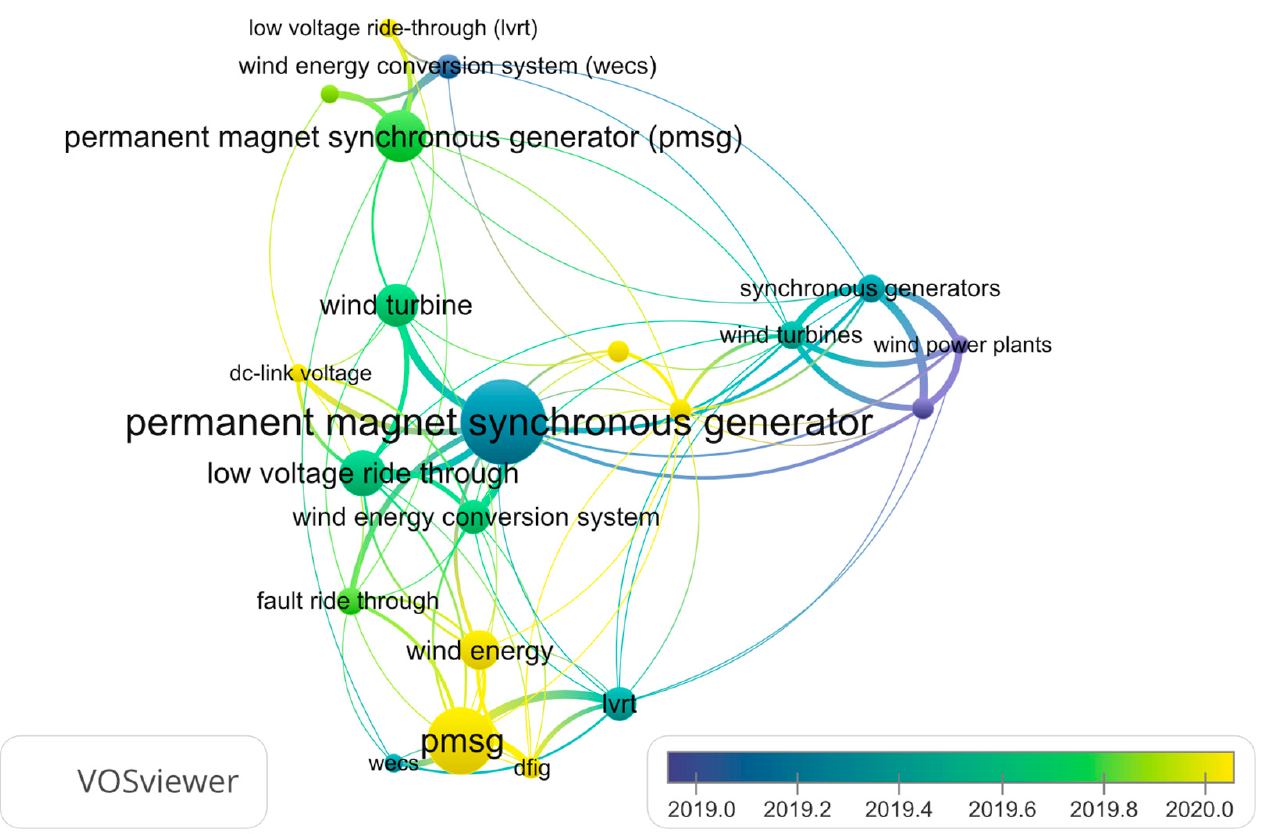
Figure 10. Keyword map of the PMSG FRT technique over time.